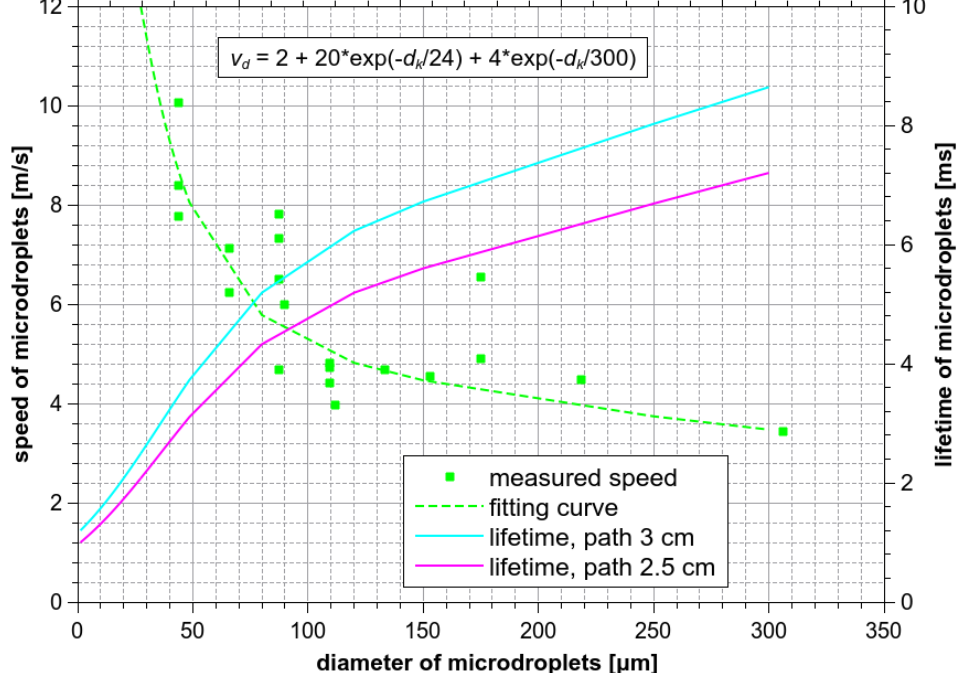
Figure 11. Speed of the ES microdroplets measured from the HS camera images and their lifetime as a function of their diameter d k .